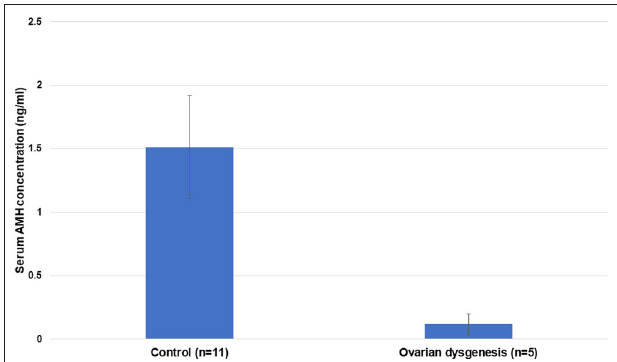
FIGURE 9 | Mean ± SEM of serum AMH concentration in control (reproductively normal) ( n = 11) and abnormal ovarian activity in females ( n = 5) ( p <